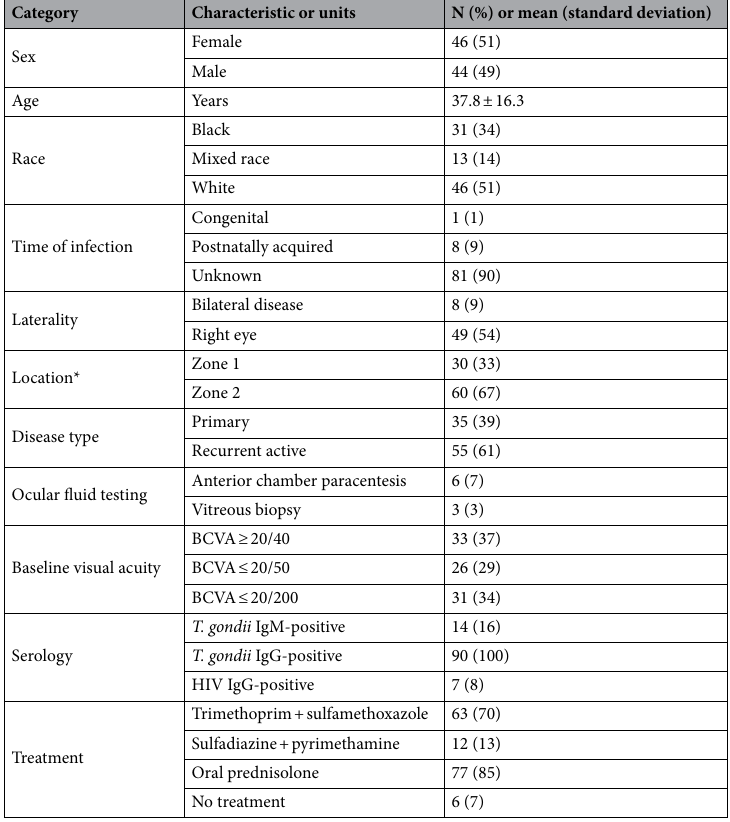
Table 1. Patient and disease characteristics (N = 90 patients). BCVA = best corrected visual acuity; Ig = immunoglobulin. *Location: Zone 1 = 3000 µm from fovea plus 1500 µm from disc margin; Zone 2 = between equator and zone